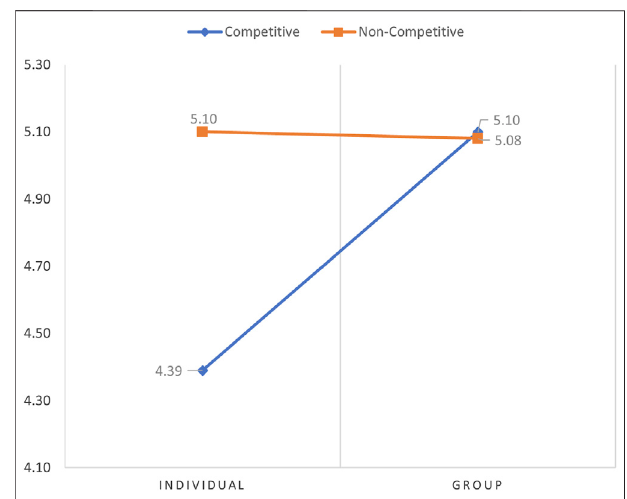
FIGURE4| Interactioneffectsofcompetitivenessandlearningformaton